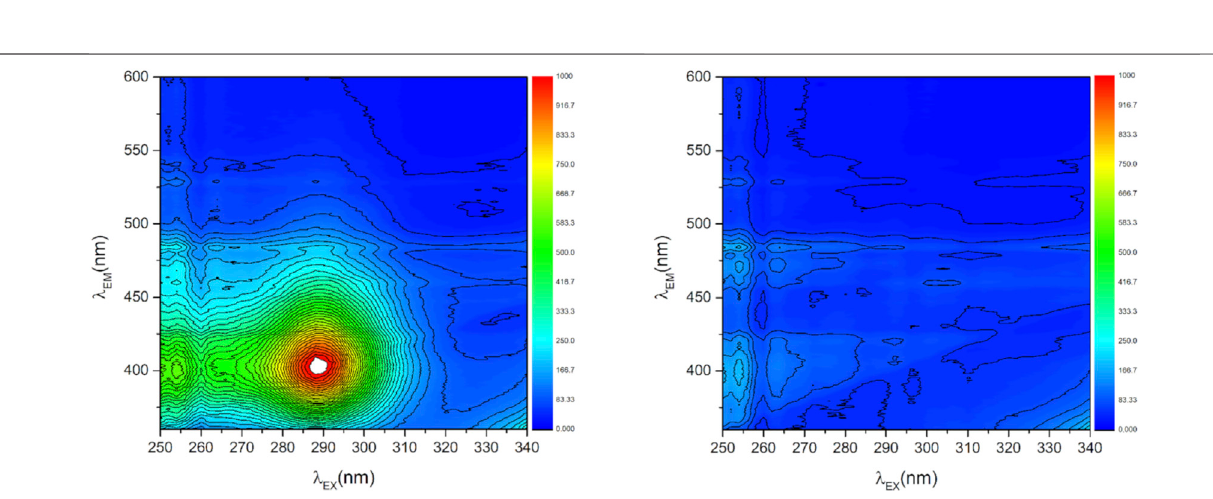
Frontiers in Chemistry |